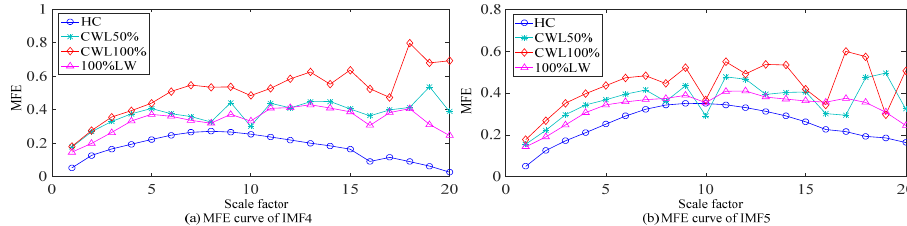
Figure 20. MFE curves of IMF4 and IMF5.